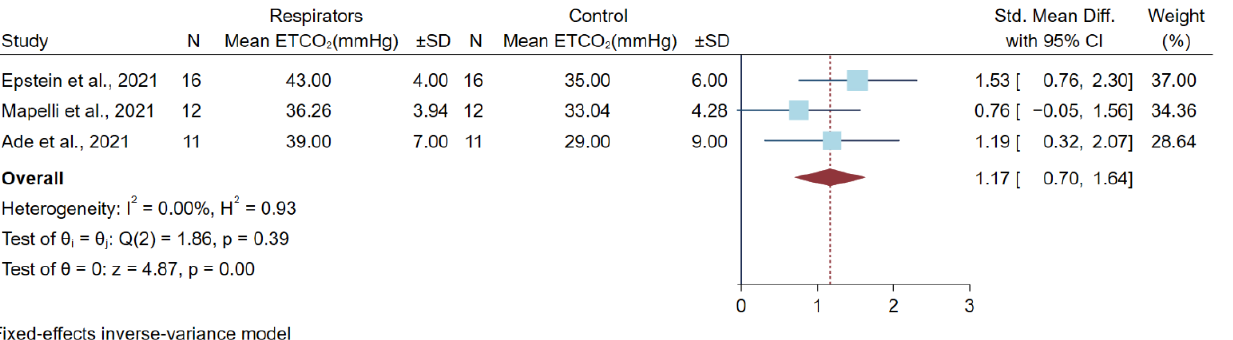
Figure 4. Differences in Carbon Dioxide Levels after a High Physical Workload. Abbreviations: CI, confidence interval; ETCO 2 , end-tidal carbon dioxide level; SD, standard deviation; Std. mean diff., standard mean difference [4,12,20].